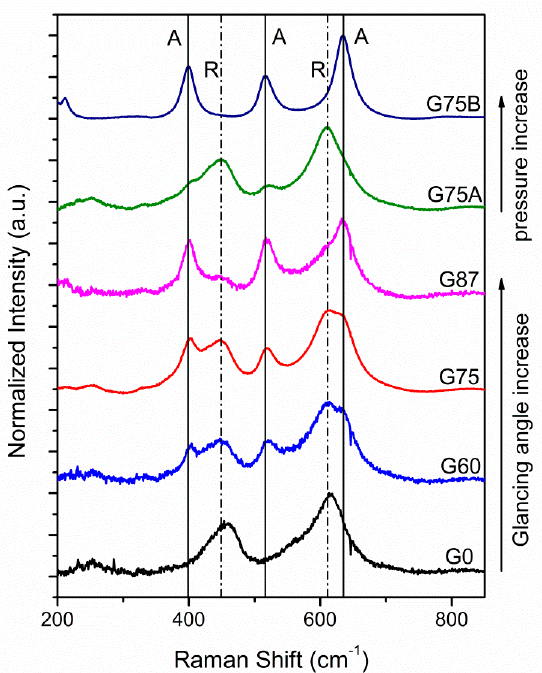
Figure 2. Raman spectra of the TiO 2 films deposited at different glancing angles and sputtering conditions.